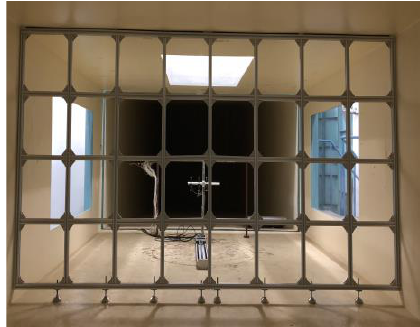
Figure 4. Grille turbulence generated device.